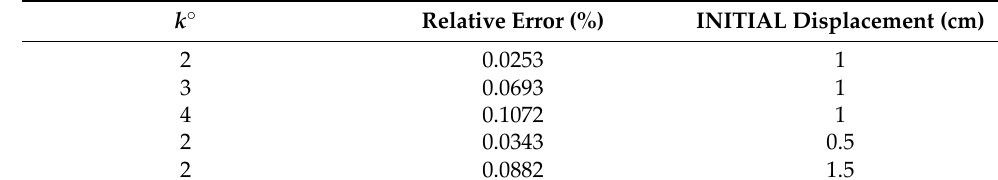
Table 2. Estimation of the PINN for the nonlinear parameter.